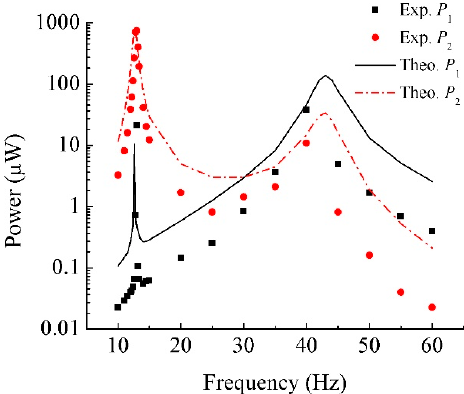
Figure 10. Comparison between experimental and theoretical output power frequency responses for the FUCHEH.